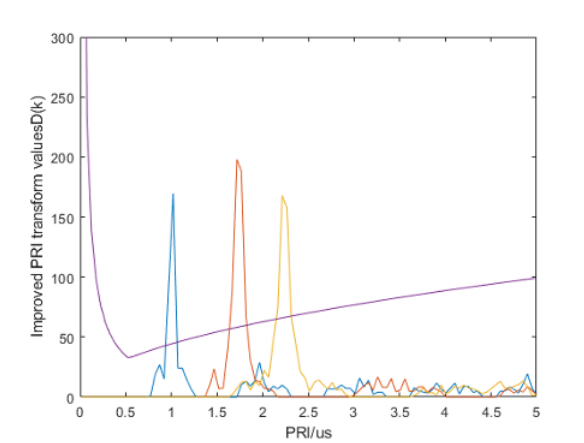
Fig. 2. Modulation identification accuracy.